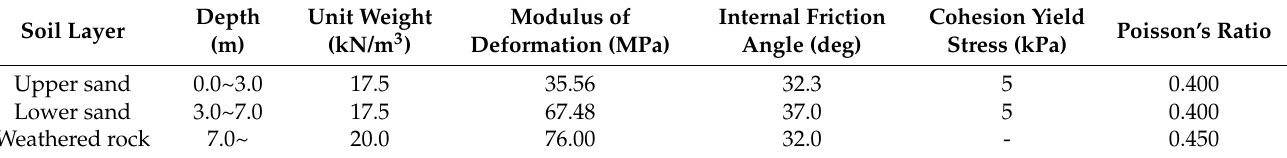
Table 1. Soil profile of survey